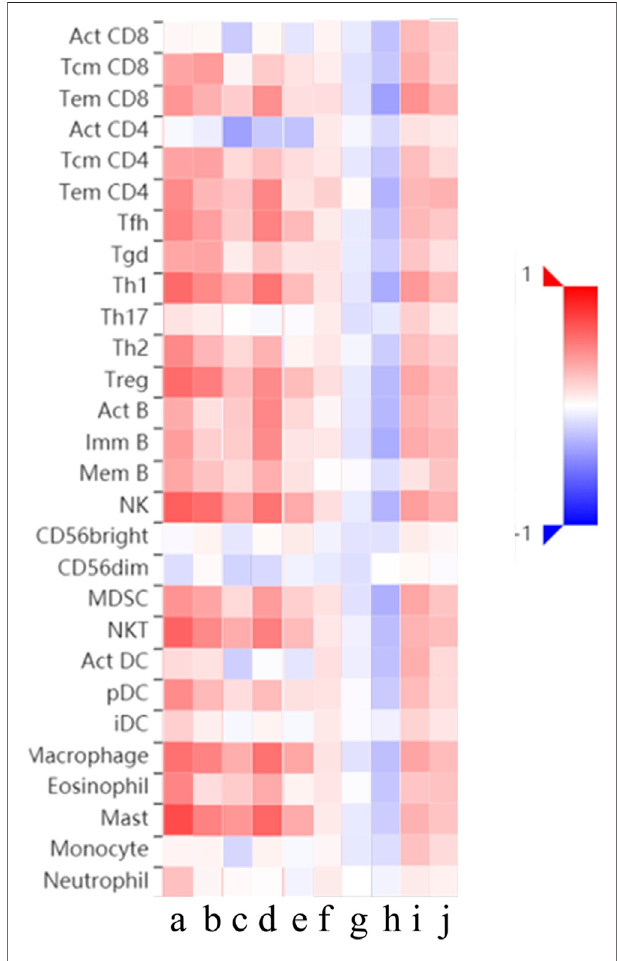
FIGURE 9 | Relations between abundance of tumor-in fi ltrating lymphocytes and expression or copy number of THBSs , a – e: expression of THBS1-5 , respectively; f – j: copy number of THBS1-5 , respectively